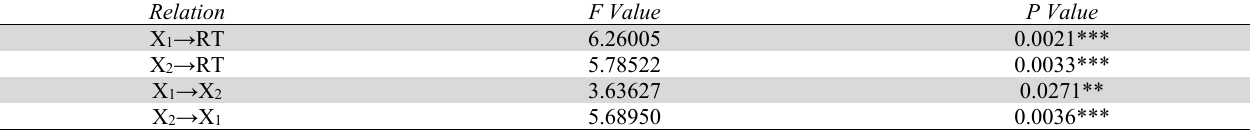
Granger causal relation test of explanatory variables and explained variables of deformed steel bars Relation F Value P Value X 1 → RT